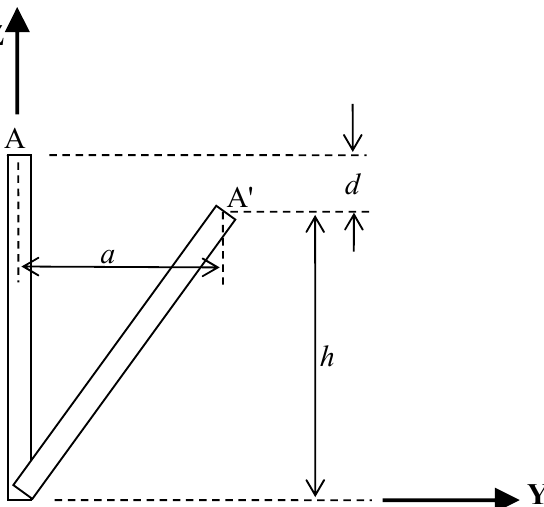
Figure 5. Schematic plot of acceleration variance in Y- and Z-directions.